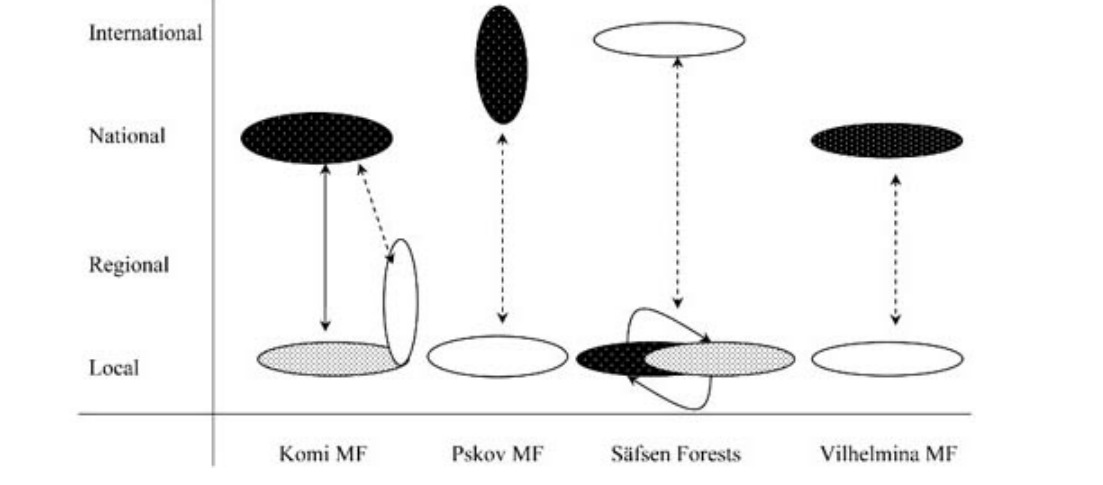
Fig. 4. The most represented levels (the vertical dimension of a governance system) of Group 1, Group 2, and Group 3 stakeholders in Russian and Swedish MF initiatives. A circle with white dots on a black background indicates a Group 1 stakeholder, a circle with black dots on a white background indicates a Group 2 stakeholder, and an empty circle indicates a Group 3 stakeholder; arrows show the interactions between